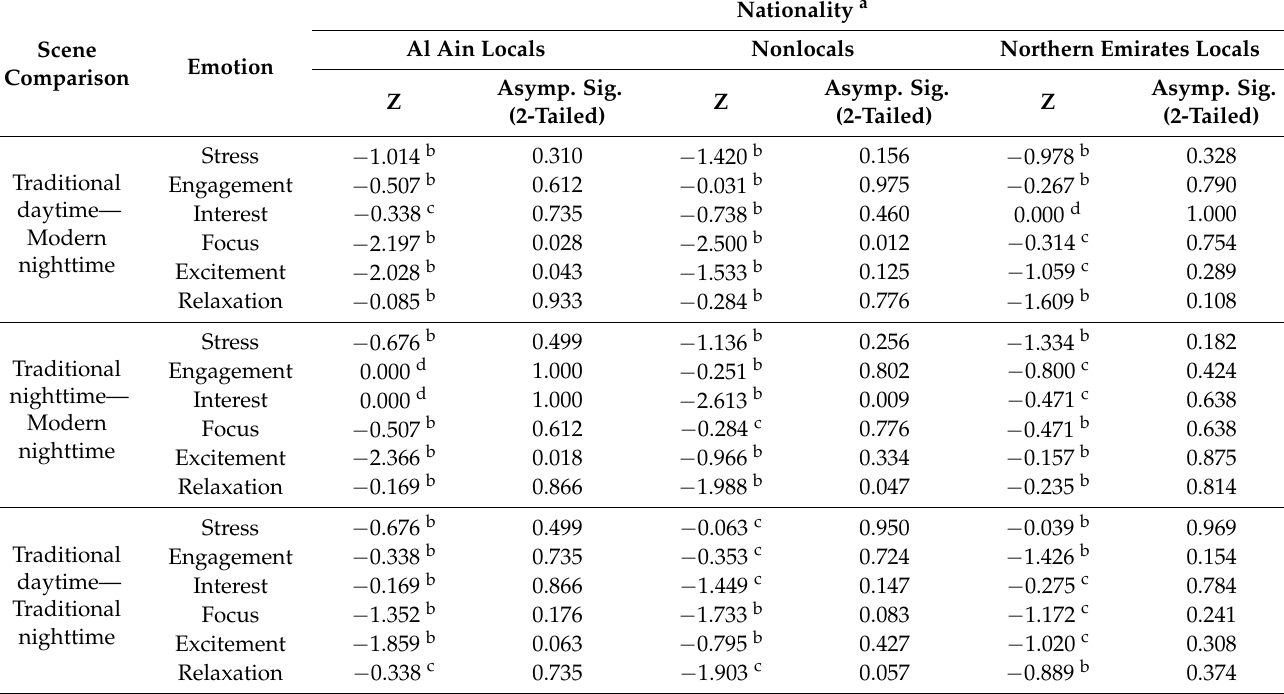
Table 5. Summary of the Wilcoxon signed-rank test results for all